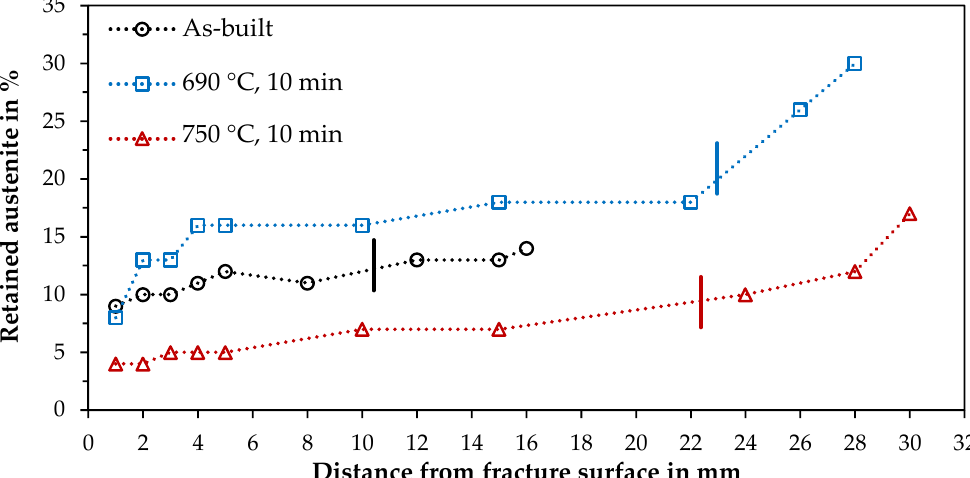
Figure 5. Retained austenite along the longitudinal axis of tested samples from the fracture surface to the thread as-built and intercritically annealed at 690 and 750 °C for 10 min. The dash marks the end of the test length (not the identical samples as for the hardness curves, therefore different lengths).